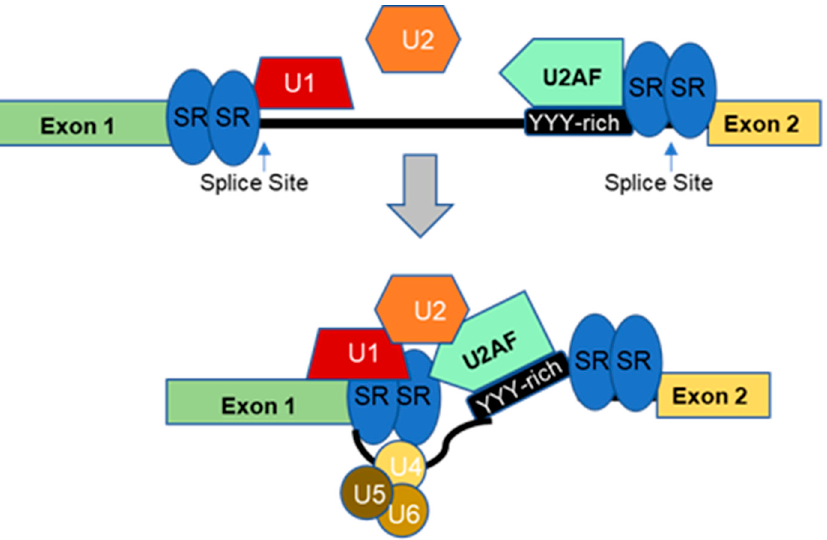
Figure 3. Schematic Illustration of Spliceosome Assembly. Alternative splicing (AS) of a pre-mRNA is carried out by the spliceosome complex. U1 ribonucleoprotein binds to the 5 ′ splice site, while U2AF binds to the 3 ′ splice site and the poly-pyrimidine tract (YYY-rich). RNA-binding proteins (RBPs), such as SR proteins, bind to the splicing recognition motif. U2 ribonucleoprotein mediates the interaction between U1 ribonucleoprotein and U2AF, leading to a conformational change of the RNA-promoting binding of the tri-ribonucleoprotein complex (U4–U5–U6). Modified after Figure 1 in Biamonti et al. (Cells 2020, 9, 34; doi:10.3390/cells9010034) [19]. Copyright lisence: https://crea- tivecommons.org/licenses/by/4.0/.